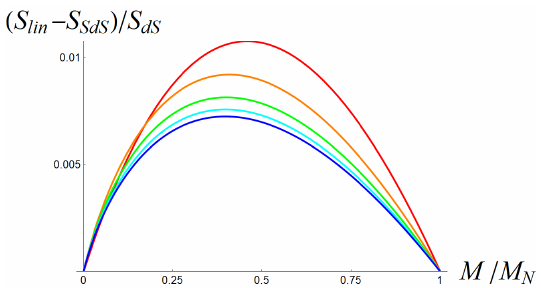
and the actual total entropy S lin . The different plots correspond to d = 4 N